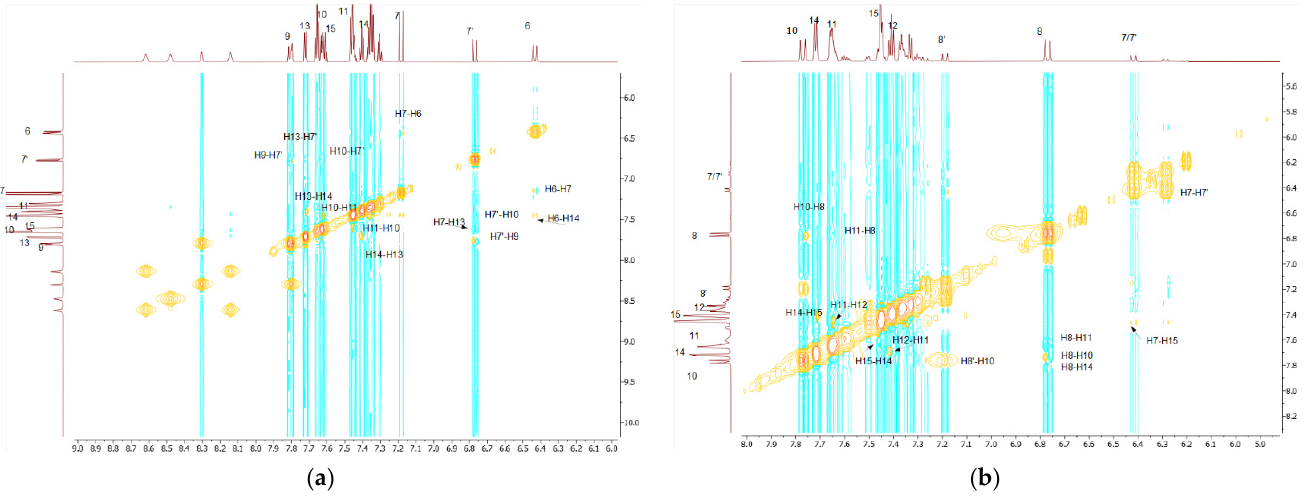
Figure 6. NOEs effects between H-7 and H-13 for KKI15 ( a ) and between H-8 and H-14 for KKI18 ( b ).